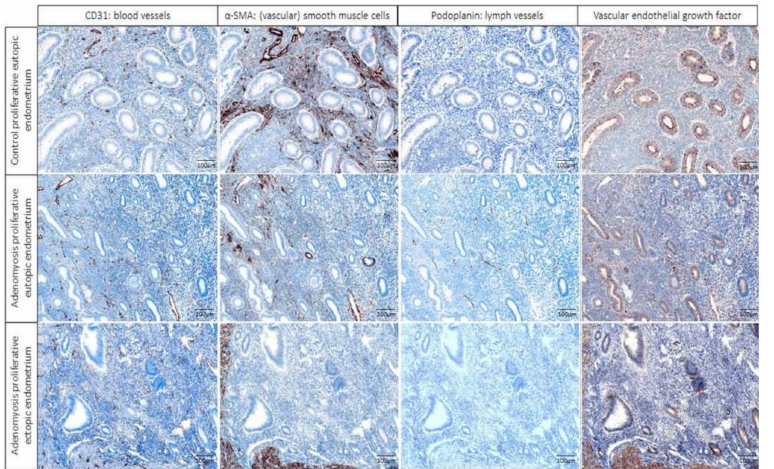
Figure 3. Representative images of the individual IHC markers using the pathology view in PerkinElmer’s inForm ® advanced image analysis software, with the primary antibody staining brown (columns from left to right of CD31, a-SMA, podoplanin, and vascular endothelial growth factor (VEGF)) and cell nuclei blue in samples of control proliferative eutopic endometrium ( top row ), ade- nomyosis proliferative eutopic endometrium ( middle row ), and adenomyosis ectopic endometrium ( bottom row